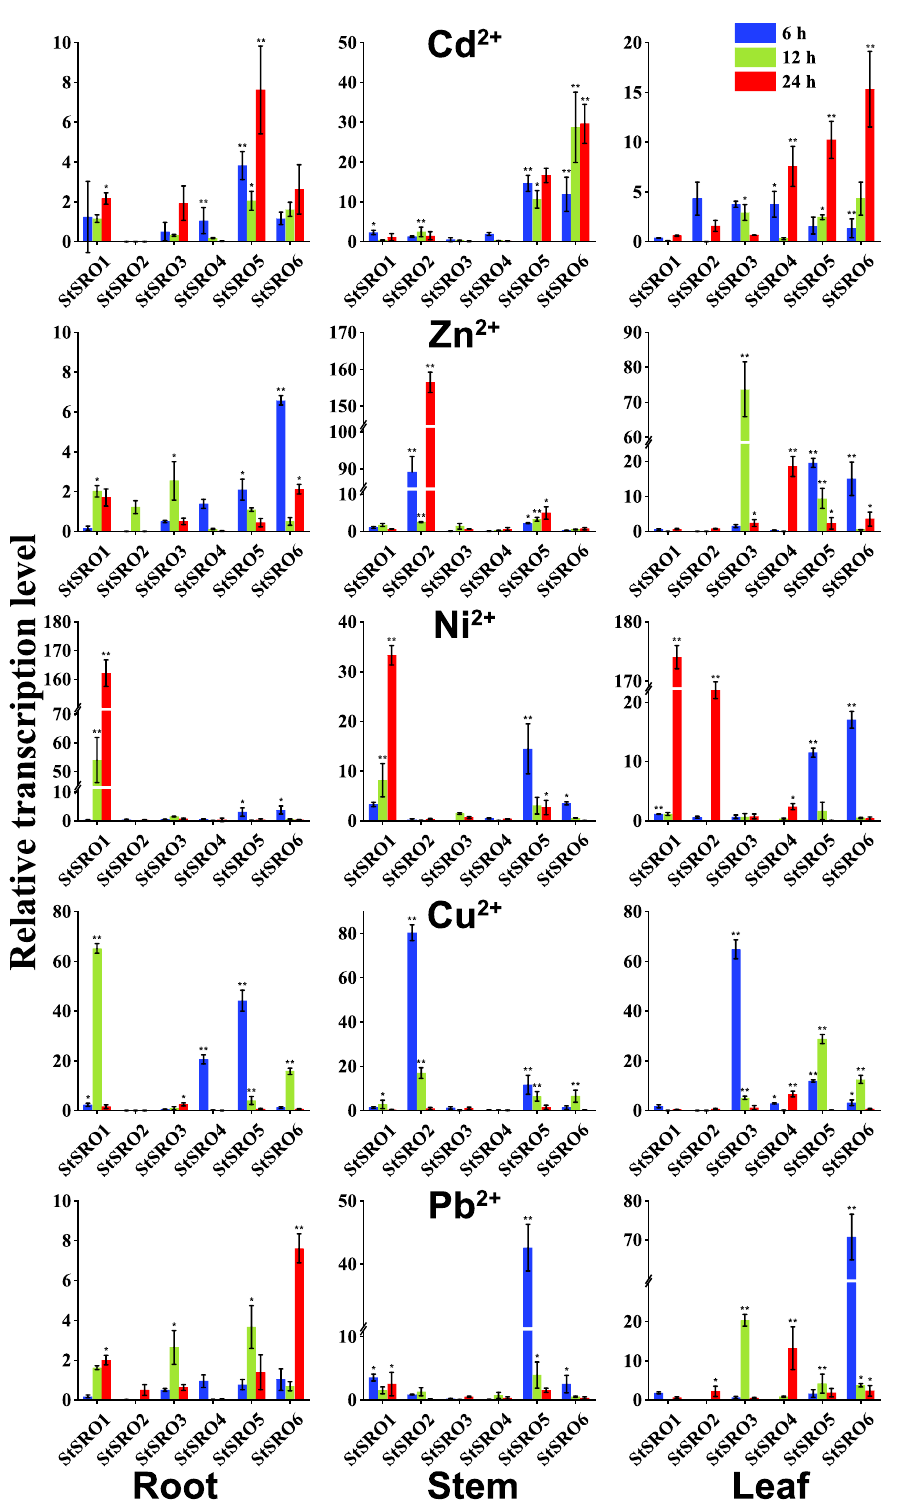
Figure 4. Expression levels of StSROs in roots, stems, and leaves under different periods of heavy metal stress (6/12/24 h), the final data were the average of three biological replicates (±SD). The vertical lines on the bar chart indicate the standard deviation, as detailed in Supplementary Table S9 (* p < 0.05 significant difference at the 0.05 level, ** p < 0.01 difference extremely significant at the 0.01 level).